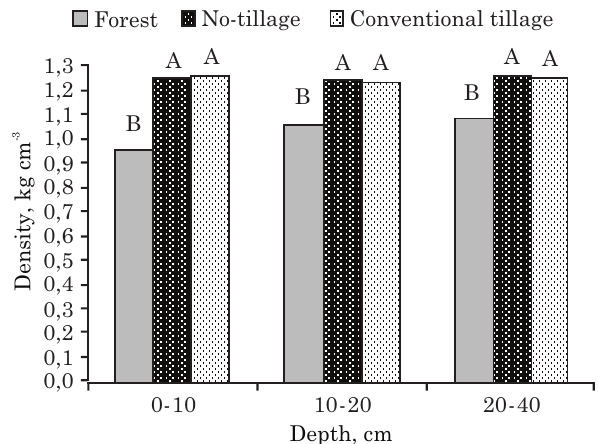
Figure 2. Variation in soil density as a function of management system and soil depth (p<0.05).